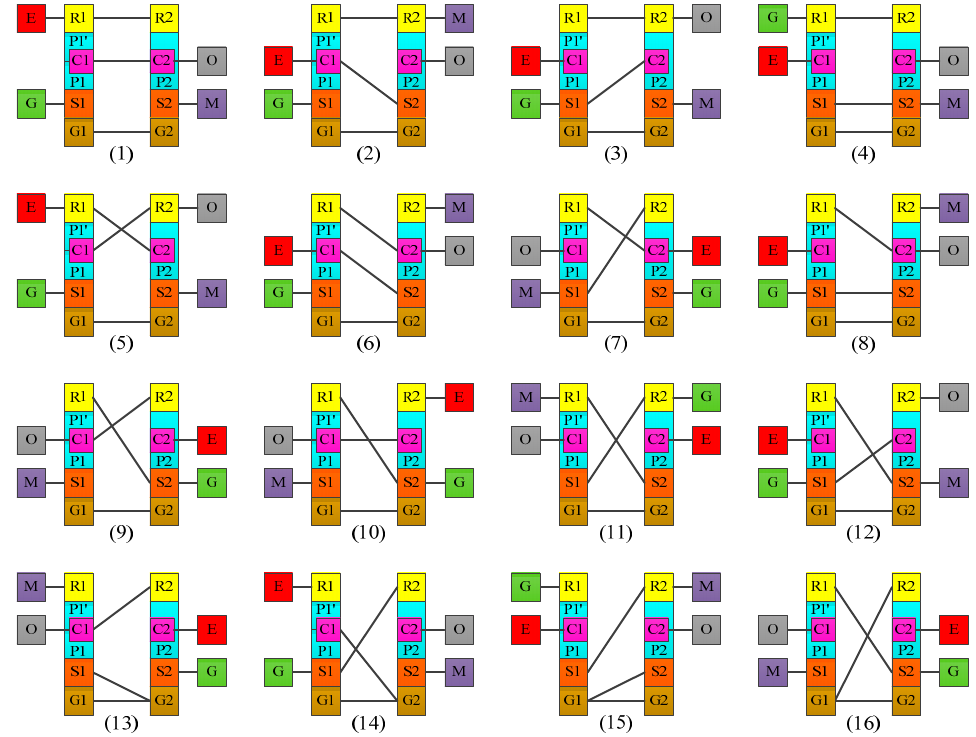
Figure 7. Partial atlas of hybrid transmission systems without clutch. E: engine; M: motor; G: generator; O: output shaft.